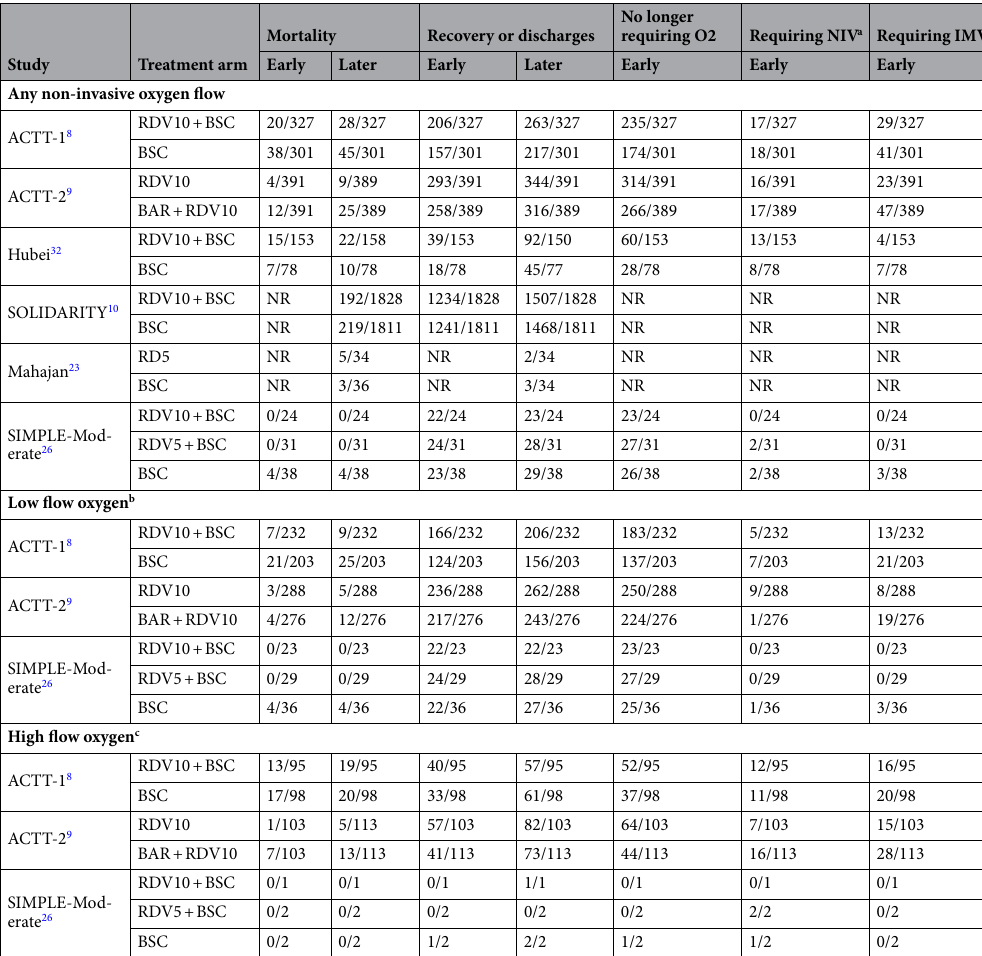
Table 3. Summary of outcomes by oxygen flow requirements. a Or worse. b Low-flow oxygen defined as either hospitalized and requiring any supplemental oxygen or hospitalized requiring low-flow supplemental oxygen, depending on the study. c High-flow oxygen defined as hospitalized and requiring non-invasive ventilation or use of high-flow oxygen devices, depending on the study. BAR Baricitinib, BSC Best supportive care, IMV Invasive mecahanical ventilation, NIV Non-invasive ventilation, NR Not reported, O2 Oxygen; RDV5 Remdesivir over 5 days, RDV10 Remdesivir over 10